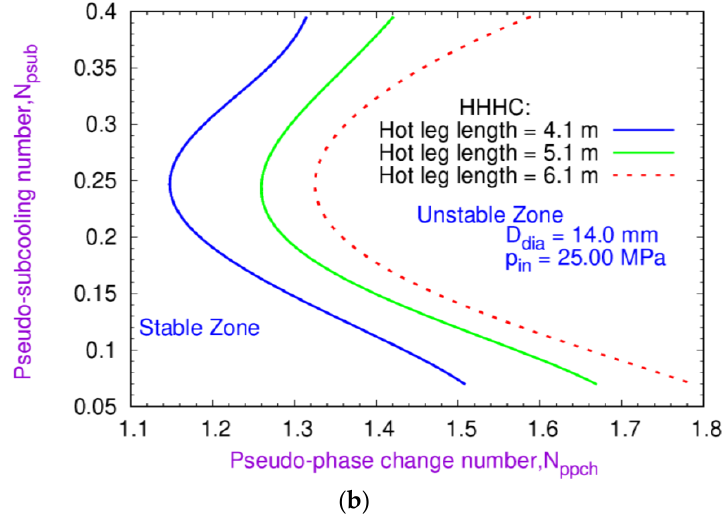
Figure 8. Effect of hot leg length on the DWI of the loop: ( a ) specific enthalpy vs. power; ( b ) (N ppch ) vs. (N psub ) plane.